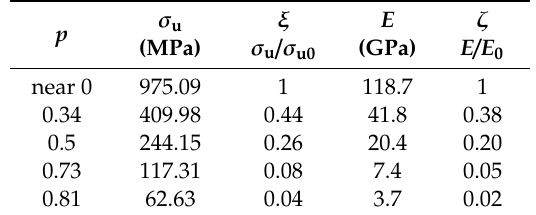
Table 6. Values of the coefficients ξ and ζ for samples of Ti6Al4V titanium alloy with different porosity obtained by the LPBF method during the tensile test.